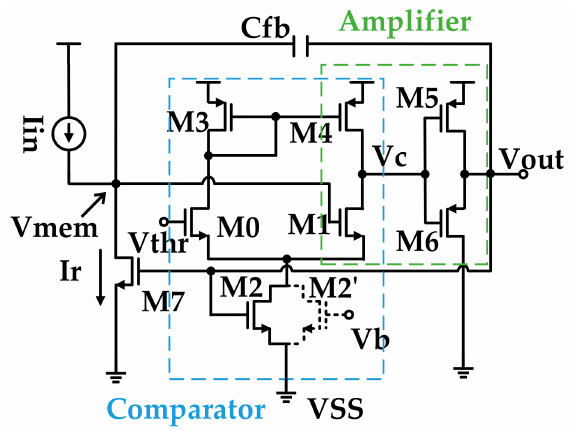
Figure 5. Schematic of the artificial neuron designed in the work. The comparator and the amplifier share the branch of M1 and M4 together. M2 is the tail current source supplied by the V out in this work. M2 (cid:48) is the common tail current source supplied by the reference voltage V b